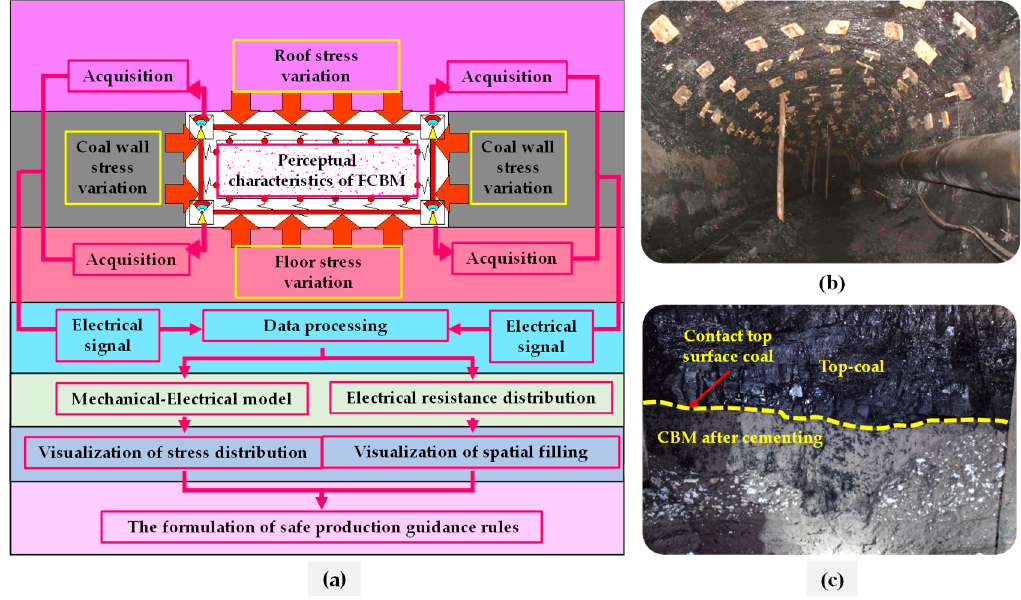
Figure 8. Illustration of specific application design of cemented backfilling. ( a ) Design flow of Functional Cemented Backfilling Materials (FCBM) ( b ) Tunnel segment to be filled by CBM or FCBM ( c ) Contact between CBM and tunnel rocks.